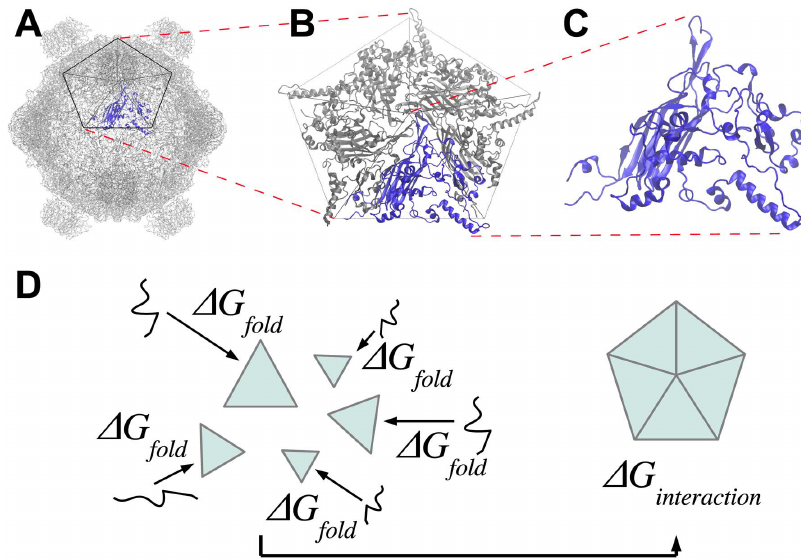
Figure 1. Model systems used in current study. (A) The capsid of Q X174 consists of multiple copies of several kinds of proteins. The pentagon highlights a pentameric subunit that has five copies of coat protein F. (B) One pentameric subunit used in this study to estimate protein-protein binding stabilities, DD G bind . (C) A single protein F used in this study to estimate protein folding stability, DD G fold . (D) For each substitution within 1 DNA change of the reference sequence, we calculated DD G fold and DD G bind using FoldX and the conceptual model shown. For a given amino acid sequence of the F protein, we have D G bind = D G interaction – 5 D G fold . Letting the subscripts sub and ref refer to the protein with and without a given substitution, the relative binding stability is then calculated as DD G bind = D G bind,sub – D G bind,ref and the relative folding stability is calculated as